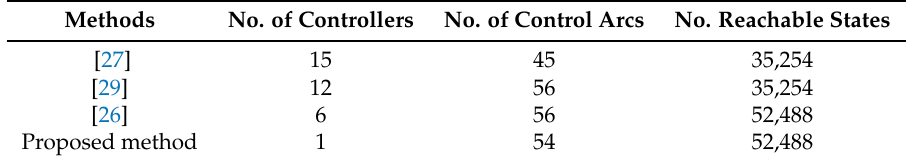
Table 5. Performance comparison of the proposed method with some of the available methods in the